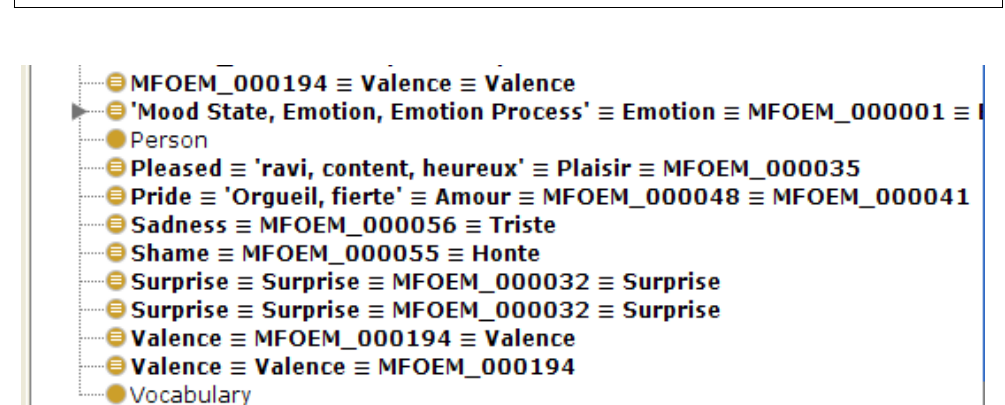
Figure 6. Subset of the emotion ontology (visualization under the Protege ontology